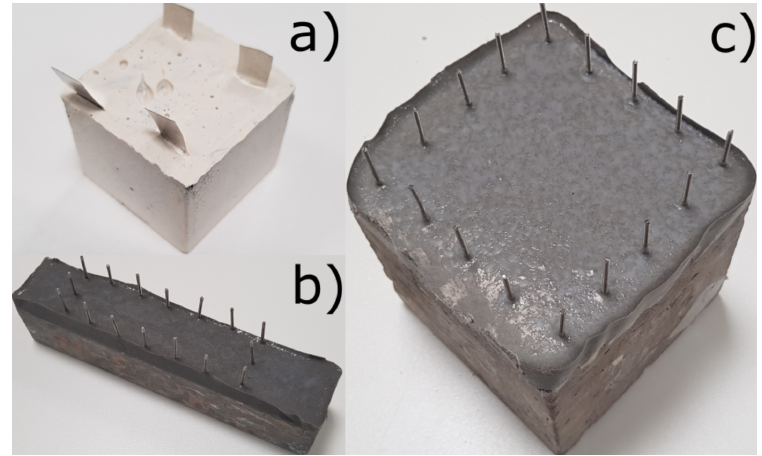
Figure 1. ( a ) Pure geopolymer sample used for benchmarking, ( b ) 40 × 40 × 200 mm beam and ( c ) 100 × 100 × 100 mm cube with instrumented AAM repair. Table 1. Mix design for the self-sensing AAM repair